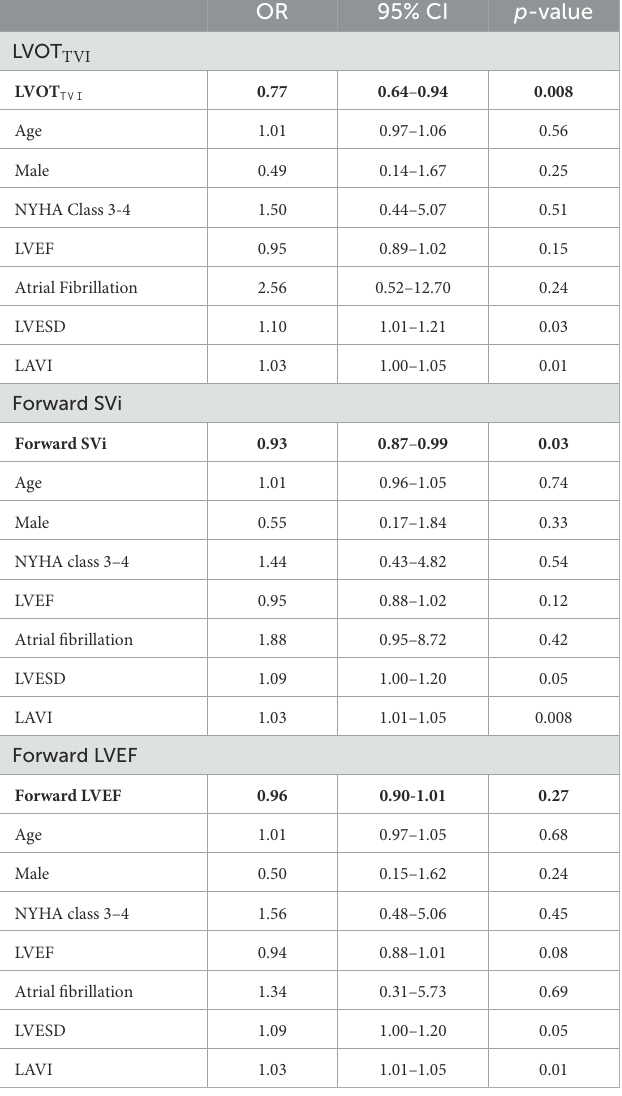
TABLE 5 Multivariable risk factor analysis for predicting post-operative LV systolic dysfunction in 198 patients subject to mitral valve repair for severe DMR after further adjustment to